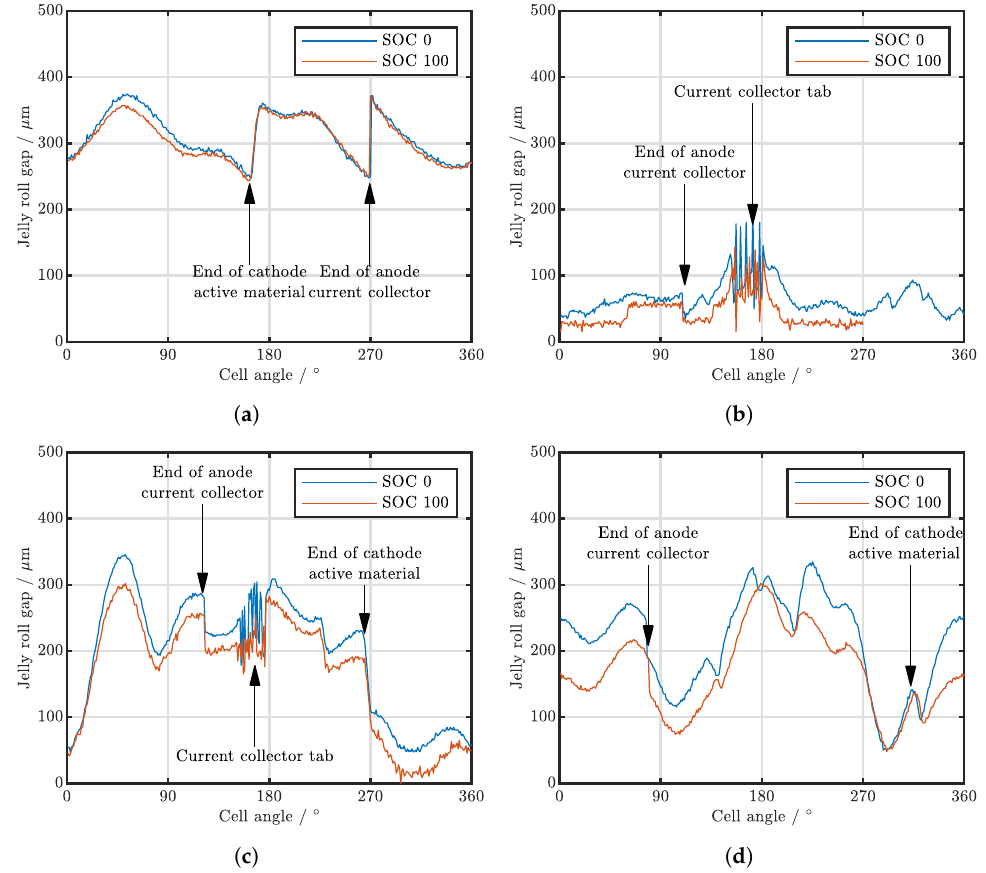
Figure 6. Jelly-roll gaps for various new 18650 lithium-ion batteries at 0% and 100% SOC. ( a ) Jelly-roll gap for an A123 APR18650M1B cell. ( b ) Jelly-roll gap for an LG INR18650MJ1 cell. ( c ) Jelly-roll gap for a SONY US18650VTC4 cell. ( d ) Jelly-roll gap for a Samsung INR18650-25RM